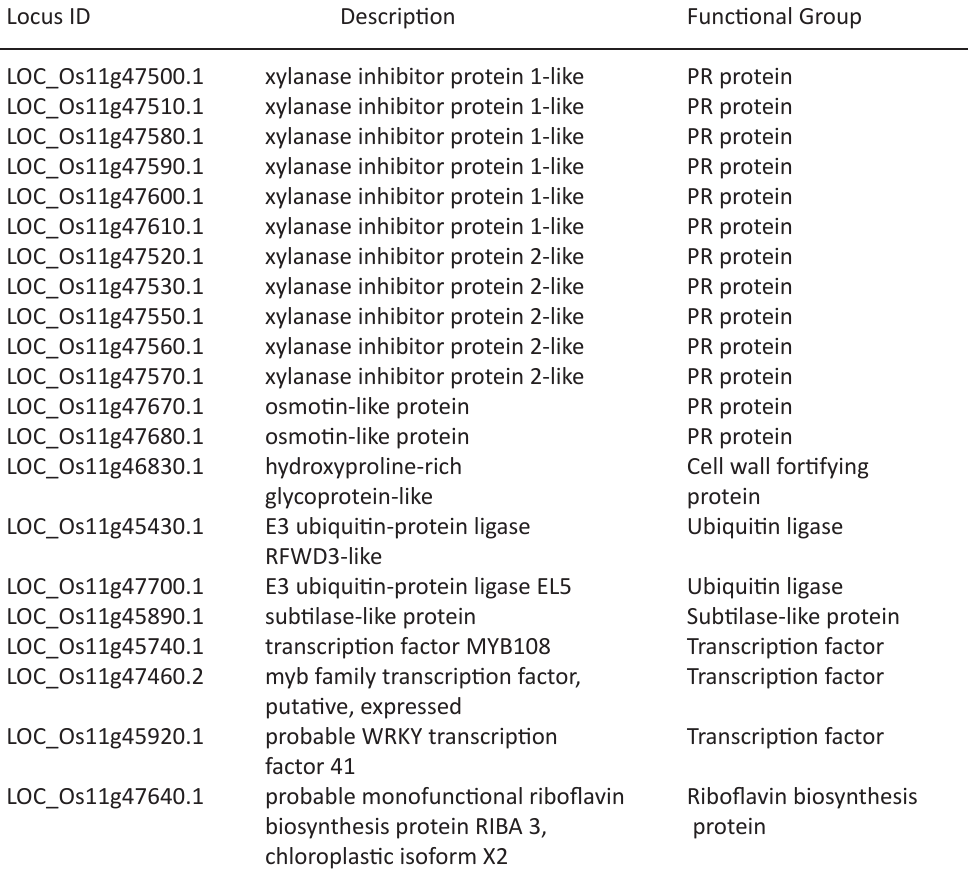
Table 2. List of defense-associated genes along with ID and functional groups Locus ID Description Functional